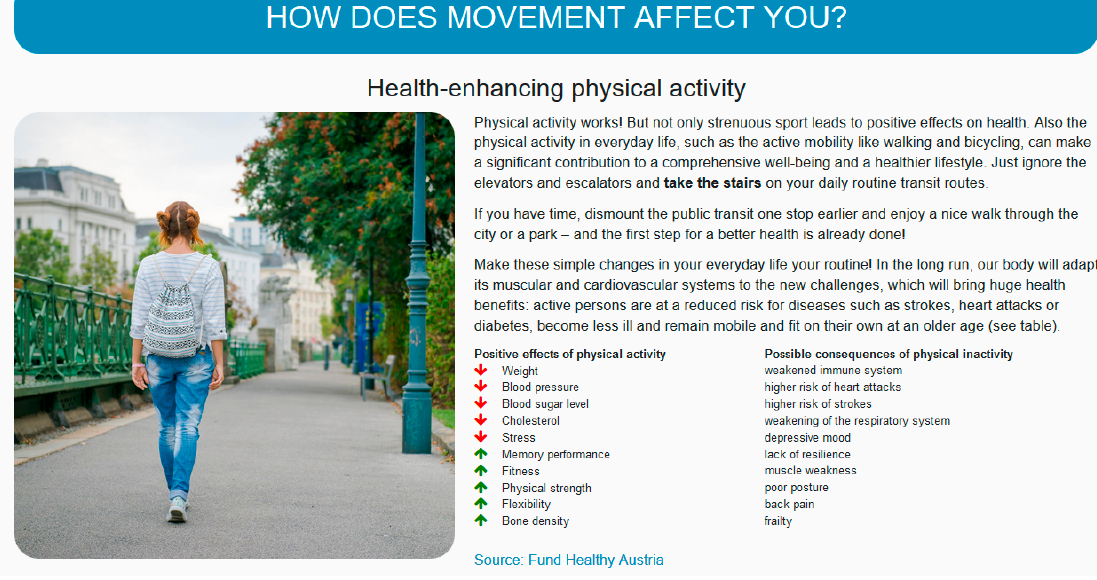
Figure 3. List of health ‐ enhancing effects of physical activity. Visualization by TraffiCon GmbH, Salzburg.